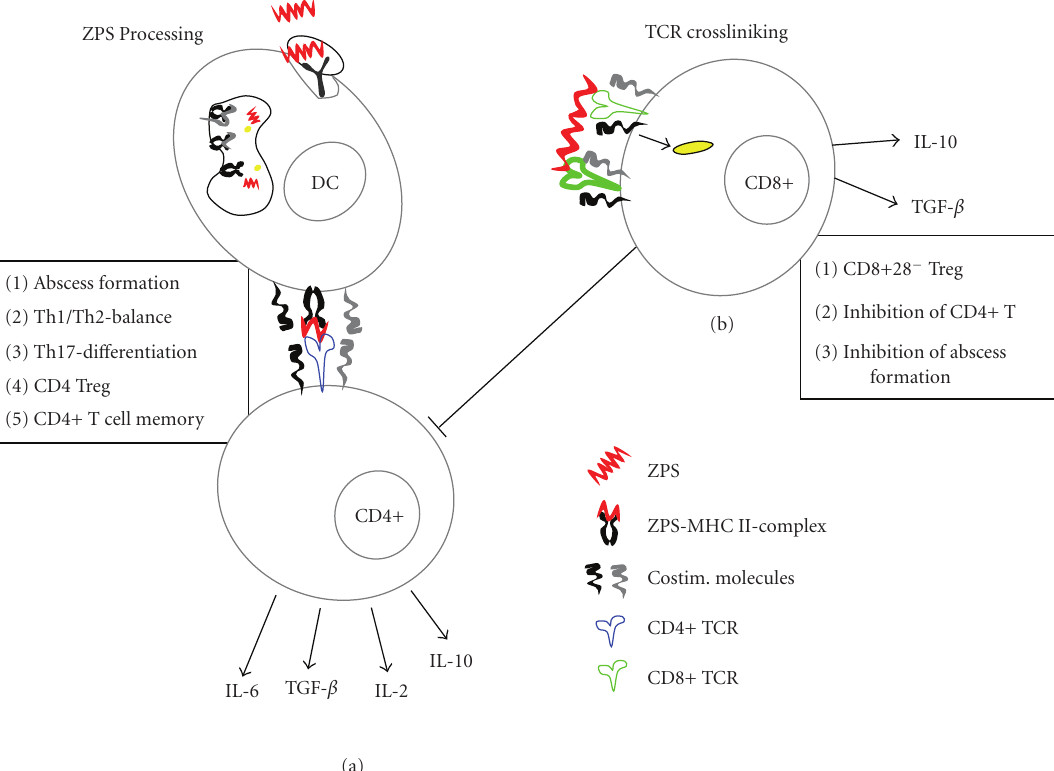
Figure 3: ZPSs modulate CD4 and CD8 T-cell responses. (a) Professional antigen presenting cells such as DCs internalize, process, and present ZPSs on MHCII molecules. The ZPS-MHCII complex is then recognized by TCRs of CD4 T cells in the presence of costimulatory molecules. This results in the activation and di ff erentiation of CD4 T cells. ZPS-activated CD4 T cells produce di ff erent cytokines and have diverse immune function such as (1) inducing intraabdominal abscess, (2) helping to balance Th1/Th2 immune responses, (3) inducing the di ff erentiation of proinflammatory IL-17 T cells, (4) inducing IL-10 producing anti-inflammatory CD4 T regs, and (5) di ff erentiate into memory phenotype. (b) In contrast to the CD4 T-cell activation which requires recognition of ZPS-MHCII complex by TCR, ZPS activation of CD8 T cells do not require antigen processing and presentation. ZPS crosslinking of the TCRs activate CD8 T cells. ZPS-activated CD8 T cells di ff erentiate into CD8+CD28 − Treg and have di ff erent immune modulatory e ff ects such as inhibition of abscess induction and CD4 T-cell